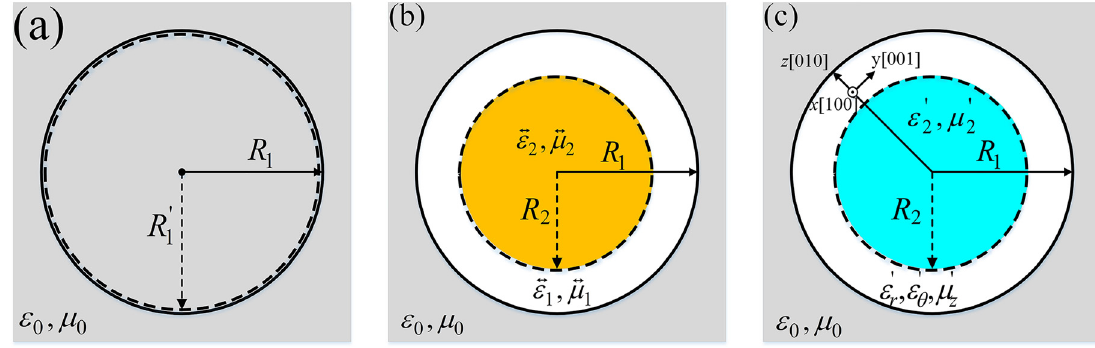
Figure 1: Perfect-invisibility concentrator. (a) Virtual space and (b) physical space of F – P transformation optics. (c) Physical space with simpli fi ed